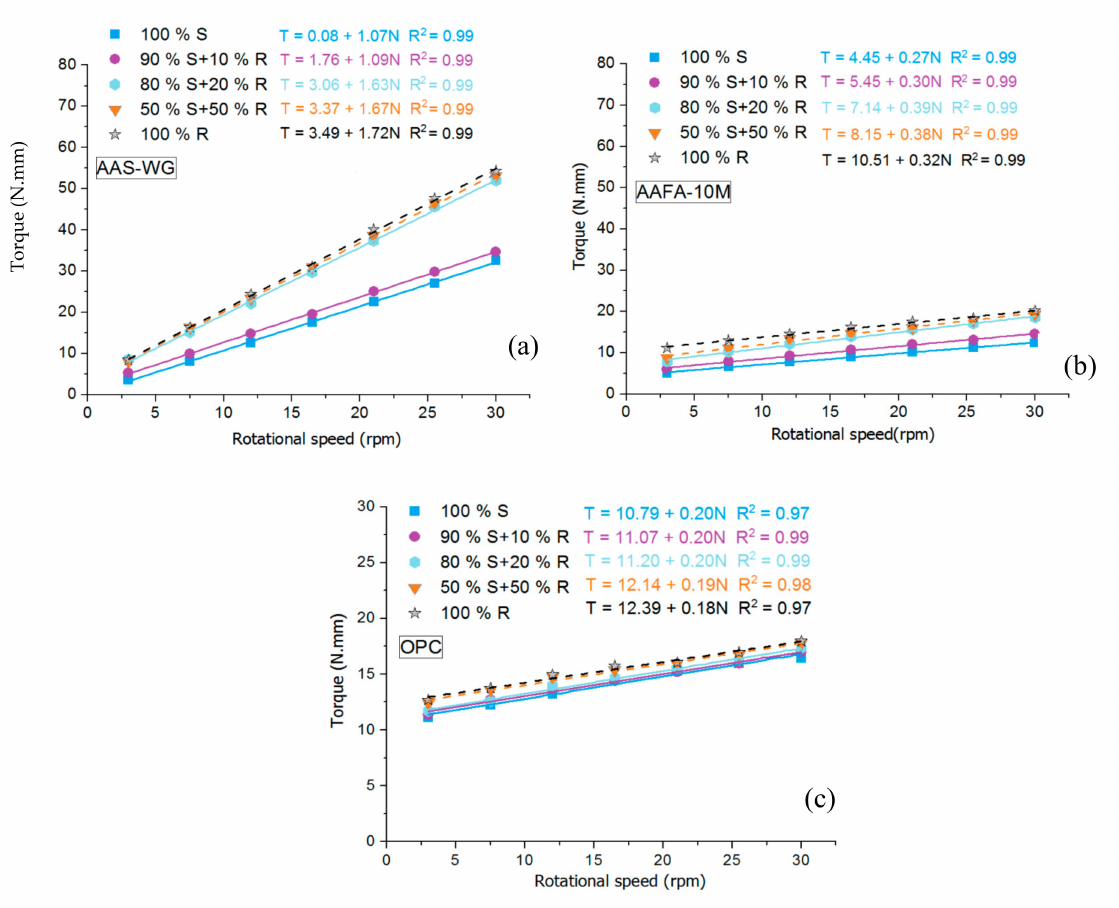
Figure 4. Flow curves for: ( a ) AAS-WG; ( b ) AAFA-10M; and ( c ) OPC with di ff erent replacement ratios (S with